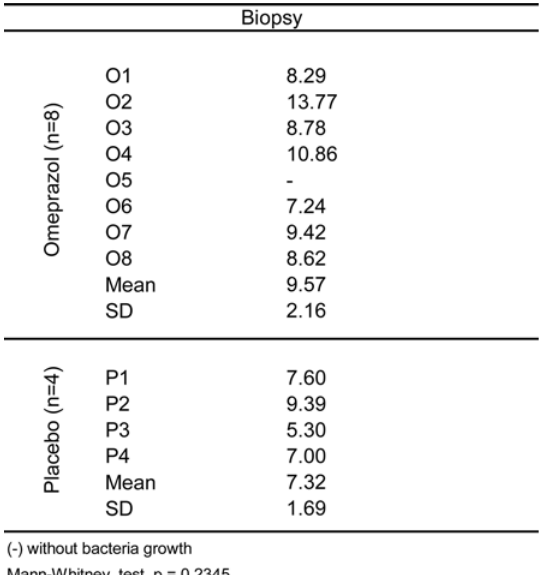
TABLE 2 - Quantity of bacteria [Ln(UFC/mL)] obtained in each sample by biopsy tecnique after administration of omeprazol/placebo.